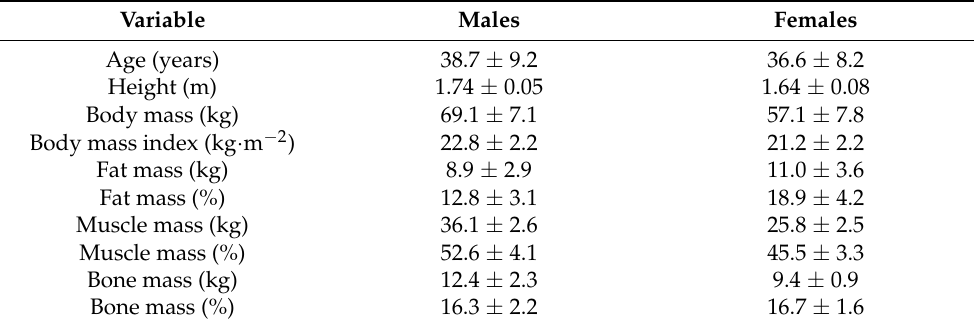
Table 1. Anthropometric data of the